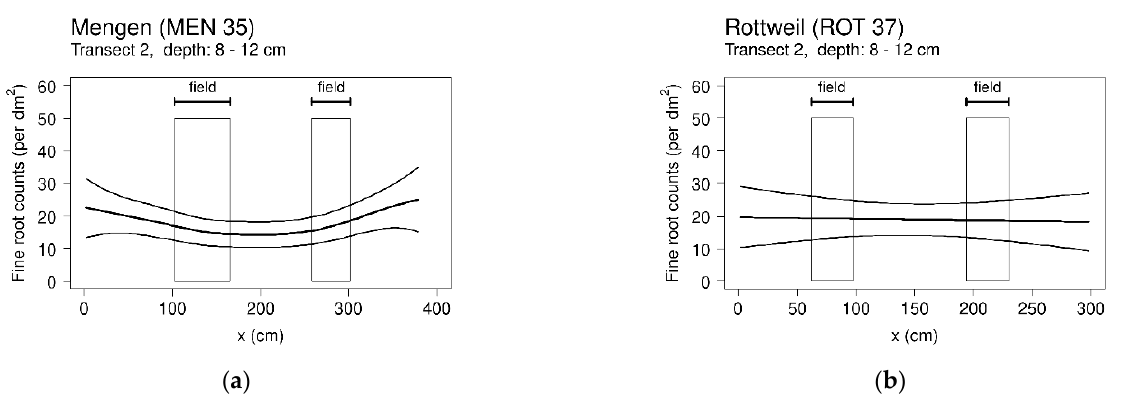
Figure 3. ( a ) The modelled fine root densities decrease from the margin zones towards the centre of skid trail transect 2 at MEN (35). ( b ) The root density curve at ROT (37) follows a straight line across the whole transect.